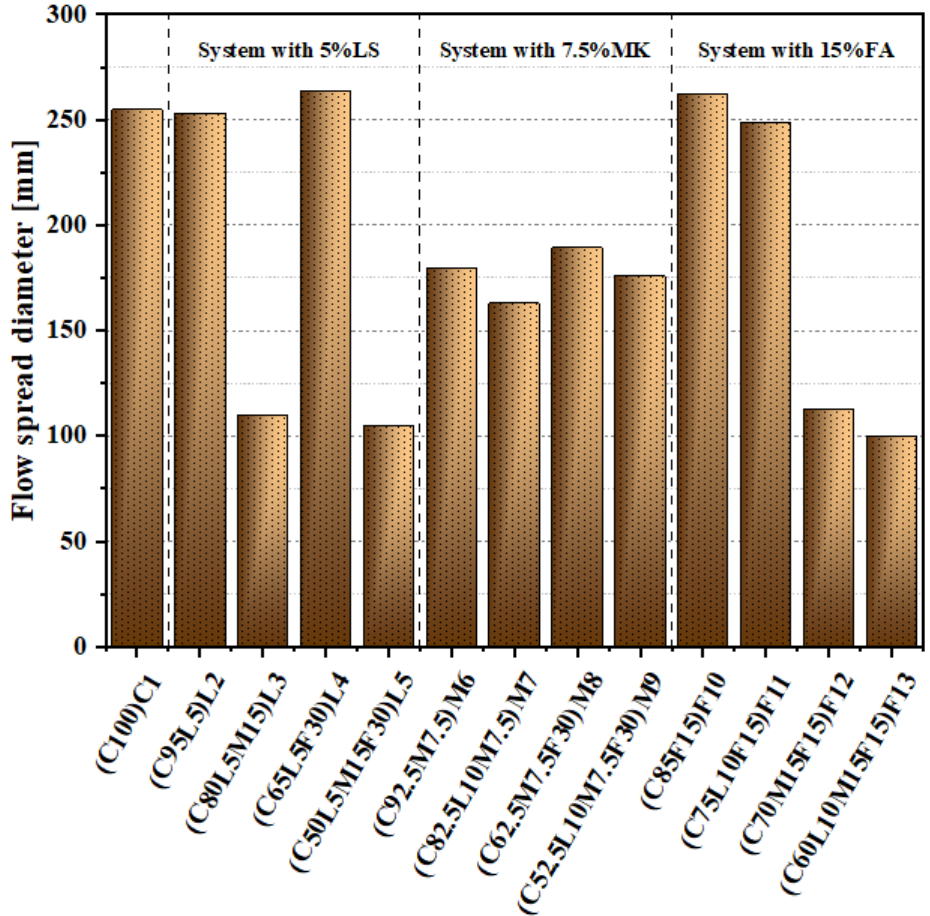
Figure 2. Flow spread values of the blended pastes.